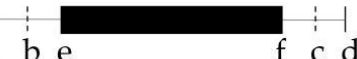
Table S2: Polymorphic marker information of insertion and deletion for SSSLs; Table S3: Polymorphic marker information of insertion and deletion for SSSLs; Table S4: TRAP-Seq FPKM expression values; Table S5: Substitute fragment information of the biological materials of 33